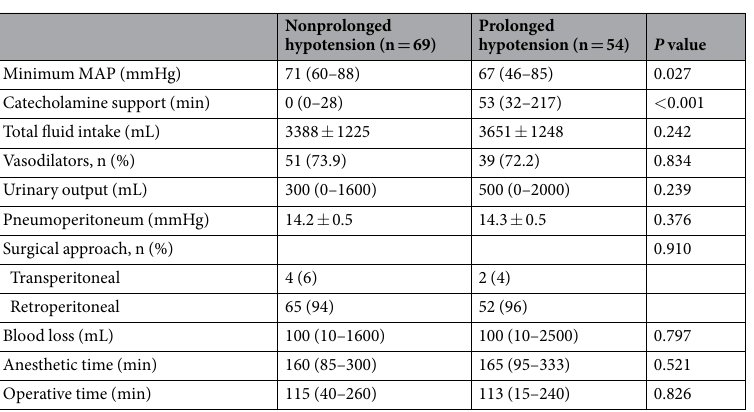
Table 2. Intraoperative variables. MAP, mean arterial blood